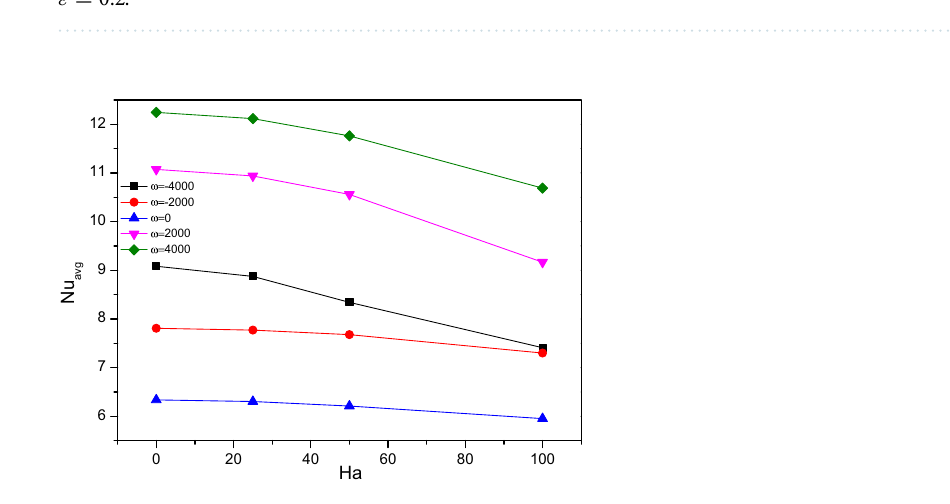
Figure 10. Variations of Nu avg with Ha for diverse Da when Ra = 10 6 , ω = 0 , φ = 0.02 , N = 4 , r = 0.1 and ε = 0.2 .